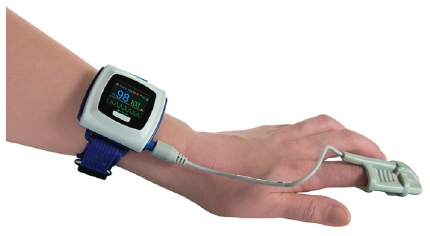
Figure 1: Smart wearable